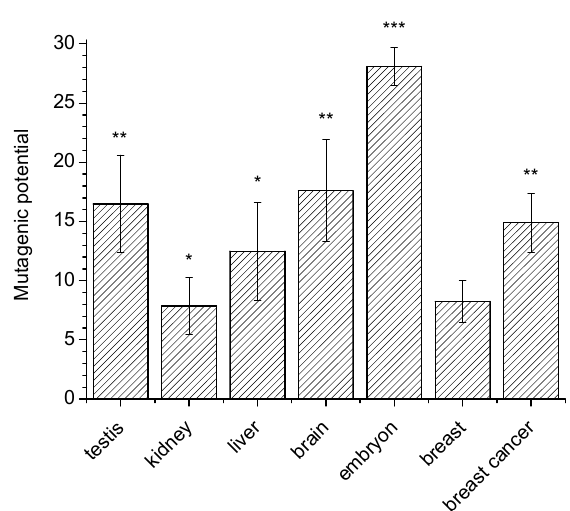
Figure 3. Values of the 8-oxoG mutagenic potential (percentage of the incorporated mutant dA relative to all incorporated nucleotides) measured by the “framed mirror” method in nuclear extracts of various mouse tissues and embryos. p Values relative to breast were: * statistically insignificant; ** p < 0.02; *** p < 0.001 (averaged from at least three experiments).